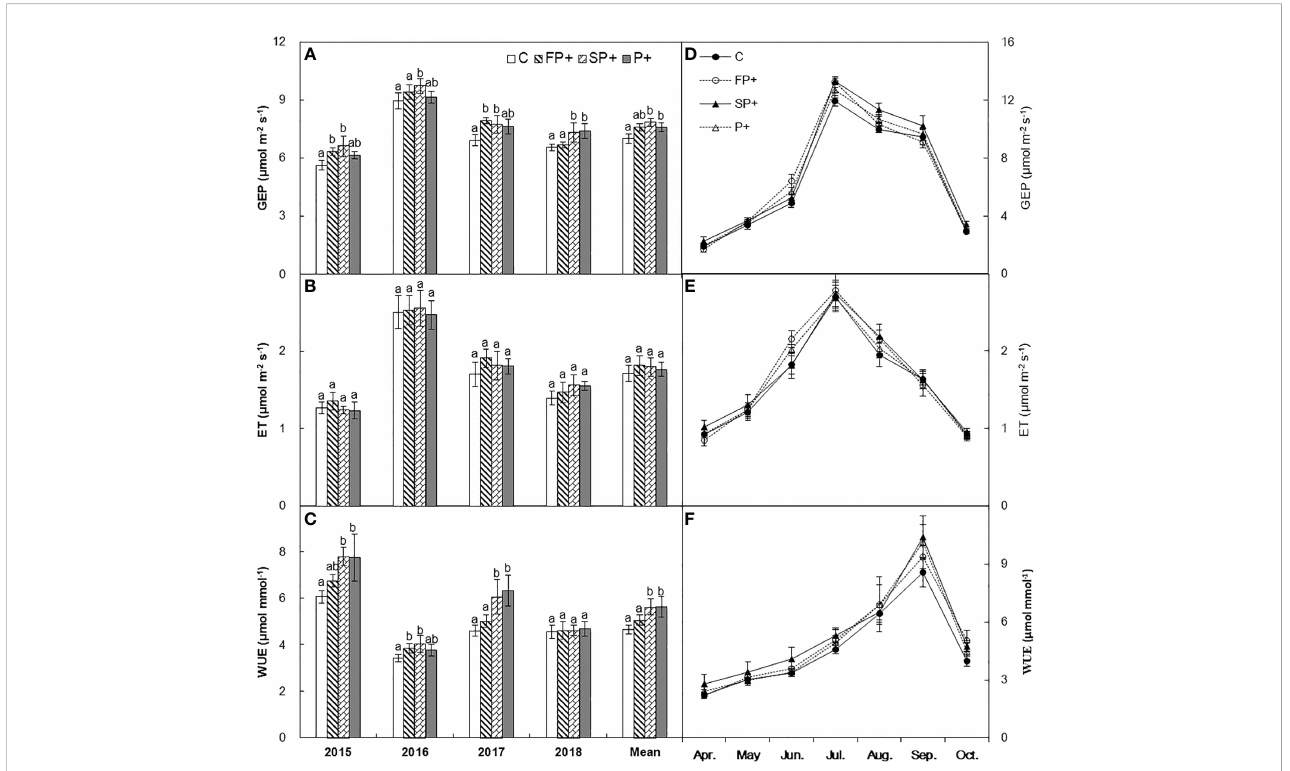
FIGURE 4 Mean and seasonal dynamics of gross ecosystem productivity (GEP) (A, D) , evapotranspiration (ET) (B, E) , and ecosystem water use ef fi ciency (WUE) (C, F) in response to increasing fi rst half and/or second half of growing-season precipitation.